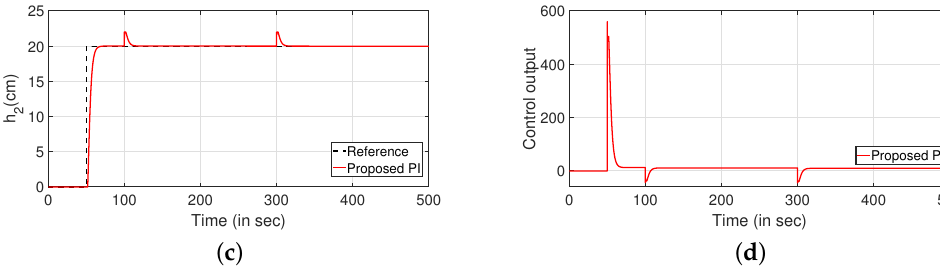
Figure 8. Regulatory response. ( a ) Level Variation in tank 1. ( b ) Control output. ( c ) Level Variation in tank 2. ( d ) Control output.